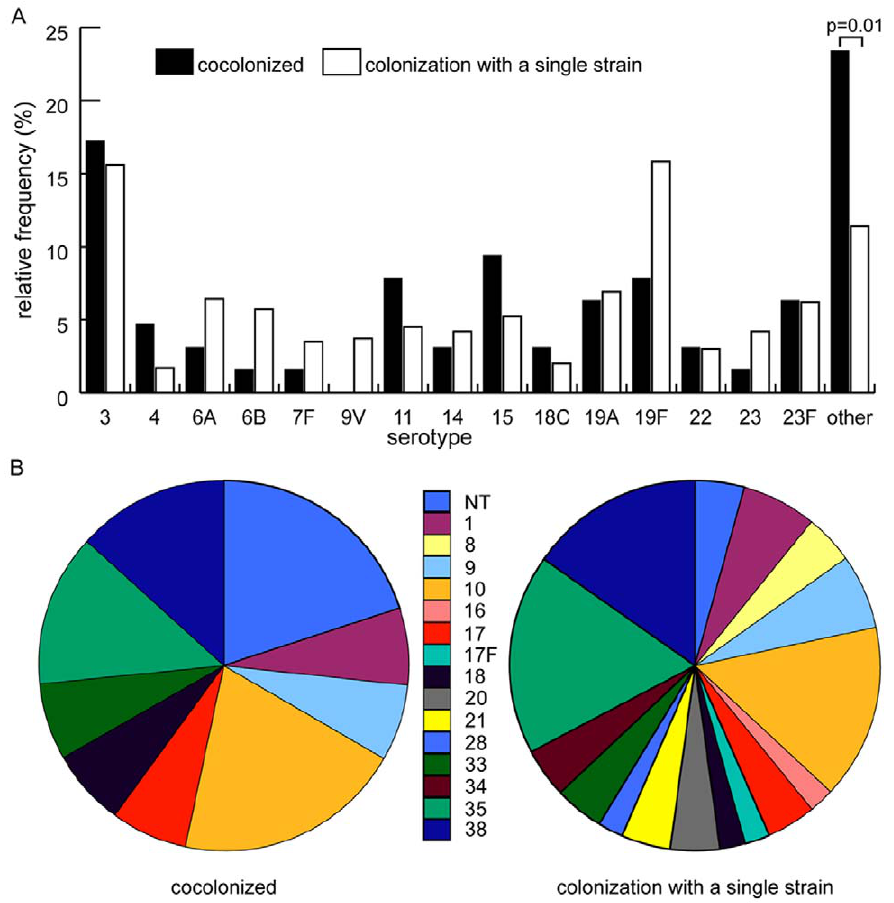
Figure 2. Serotype distribution among nasopharyngeal S.pneumoniae isolates. A. Serotype distribution among nasopharyngeal isolates (n 468) of S. pneumoniae stratified according to the detection of cocolonization or single colonization with S. pneumoniae strains. The group ‘‘cocolonizing’’ includes the 64 isolates from cocolonized samples, for which a serotype could be determined. Serotypes with a relative frequency of less than 2% are summarized as ‘‘others’’. They included serotypes/-groups 1, 8, 9 (except 9V), 10, 16, 17, 17F, 18 (except 18C), 20, 21, 28, 33, 34, 35, 38 and non-typeable isolates. The rate of rare serotypes (‘‘others’’) was significantly higher in cocolonized than in single colonized swabs (23.4% vs. 11.4%, p=0.01), but difference in the frequency of individual serotypes (for example for the serotypes 11, 15, and 19F) did not reach statistical significance. B. Distribution of rare serotypes (group ‘‘other’’ in Figure 2A) in samples with or without cocolonization. The difference between the proportion of non-typeable strains in cocolonized samples (4.7%) and in those with a single strain (0.5%) was statistically significant (Fisher’s exact test p=0.02).